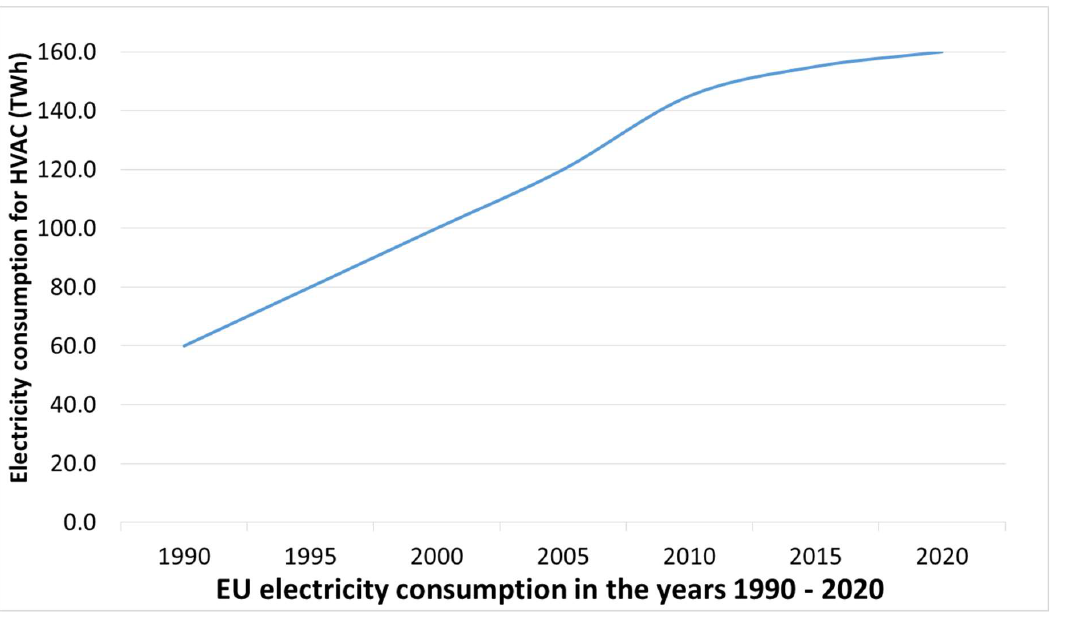
Figure 1. Energy consumption (TWh) in buildings located in the EU for cooling purposes (1990– 2020)